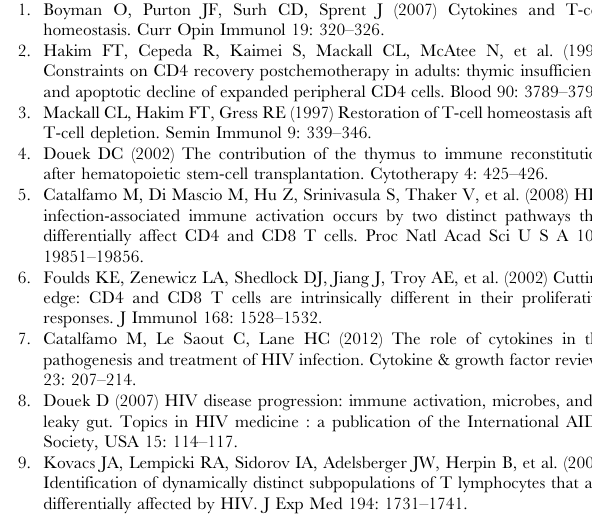
different subsets between LNs and spleen. Data from one Figure S5 Comparison of t-STAT1 and p-STAT1 expres- sion between host and donor cells after adoptive transfer into lymphoreplete B6 mice. ( a ) The levels of t- STAT1 and p-STAT1 of donor (gated CD45.2 + CD3 + ) and recipient (gated CD45.2 2 CD3 + ) T cells from lymphoreplete B6 CD45.1 (n= 6) described in Figure 5 were evaluated in LNs and spleen after in vitro stimulation with rmIFN- a (500 U/ml). A nonparametric Mann-Whitney test was performed for the comparison of the MFI of t-STAT1 ( b ) and p-STAT1 ( c ) in CD4 and CD8 T cells between CD45.2 2 CD3 + recipient (open gray symbols) and CD45.2 + CD3 + donor (solid gray symbols) T cells. Data from one representative experiment out of three, including an average of 5 mice per experiment, are presented. Figure S6 IL-7 blockade impairs donor T cell survival. Absolute numbers of CD4 + and CD8 + donor T cells in the lymphoid organs of the transferred mice were enumerated at day five post transfer into ( a ) replete B6 CD45.1 (n= 5; gray symbols), lymphopenic RAG 2 / 2 (n =5; black symbols) and IL-7 2 / 2 x RAG 2 / 2 (n =4; blue symbol) described in Figure 6a, b and ( b ) non irradiated (n= 3, gray symbols) and irradiated B6 hosts treated or not with anti-IL-7 and anti-IL-7R mAbs ( a -IL-7 + a -IL- 7R; n= 3, open red symbols and Isotype control; n= 3, filled red symbols) described in Figure 6c, d. Data are from one